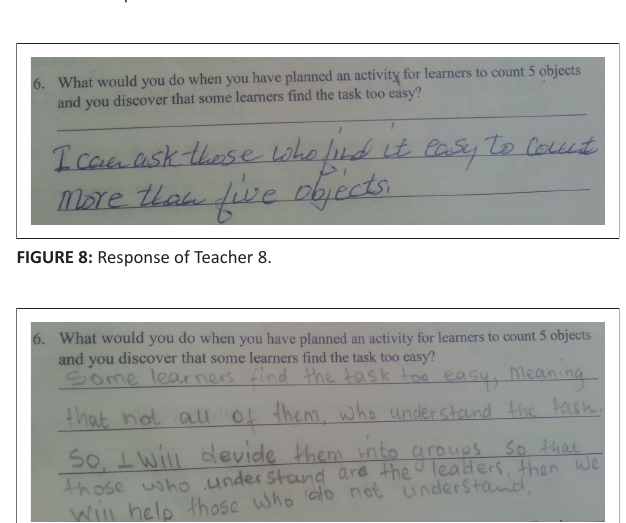
FIGURE 7: Response of Teacher